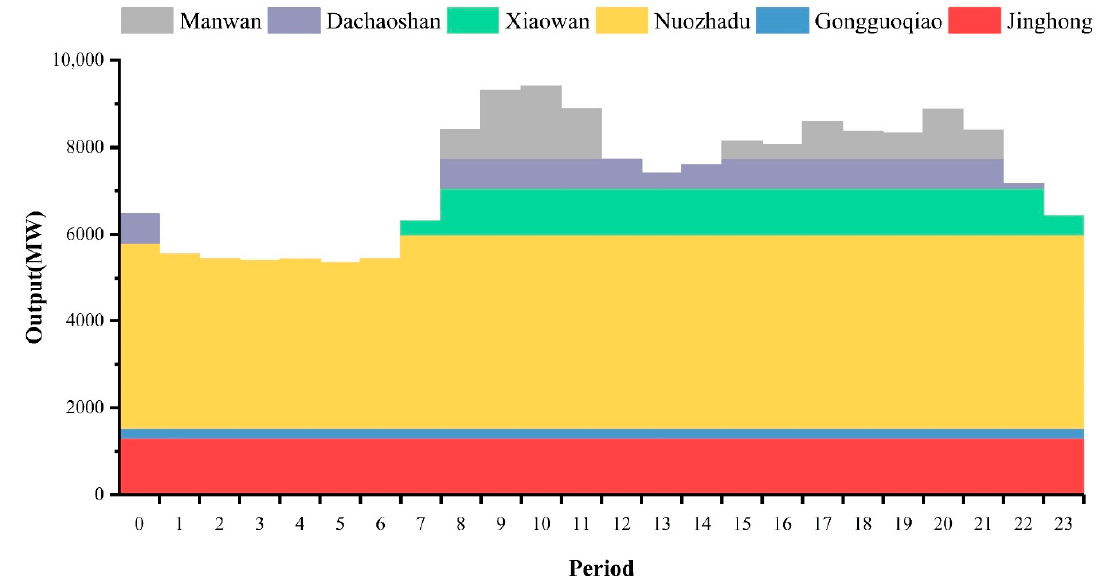
Figure 11. Hourly power generations of plants (without operating zones enforced).